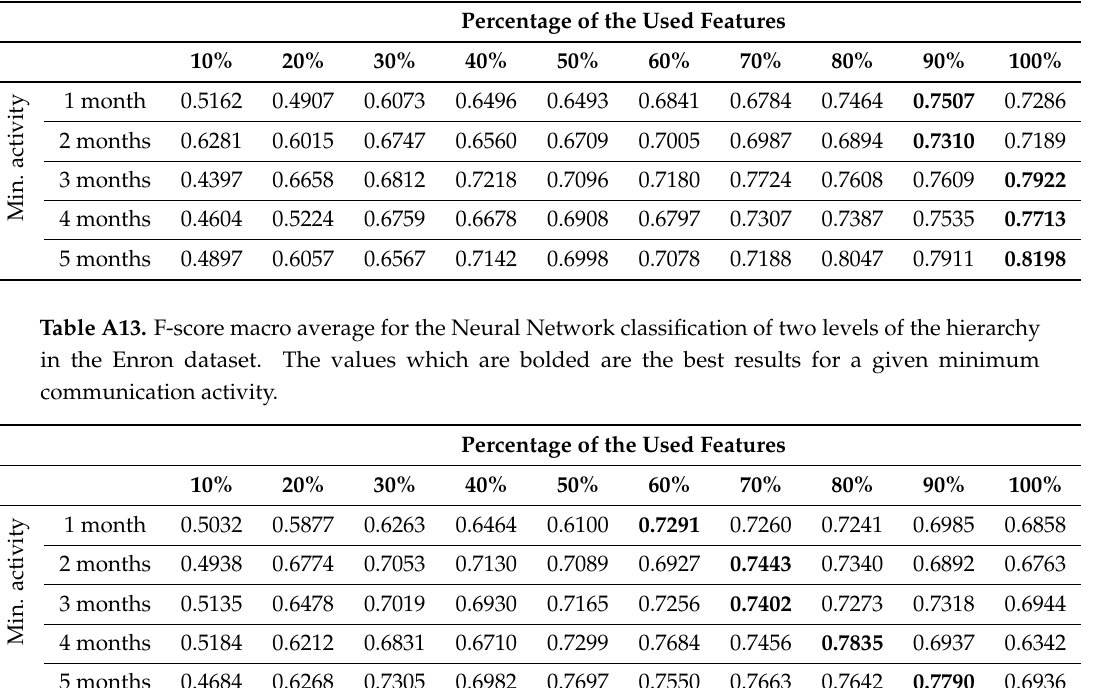
Table A12. F-score macro average for the Random Forest classification of two levels of the hierarchy in the Enron dataset. The values which are bolded are the best results for a given minimum communication activity.